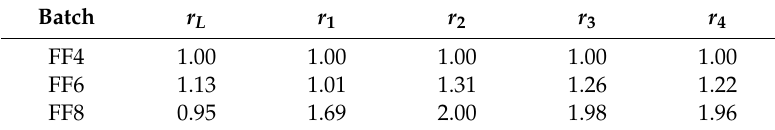
Table 7. Flexural strength ratio ( r j ) of all batches compared to